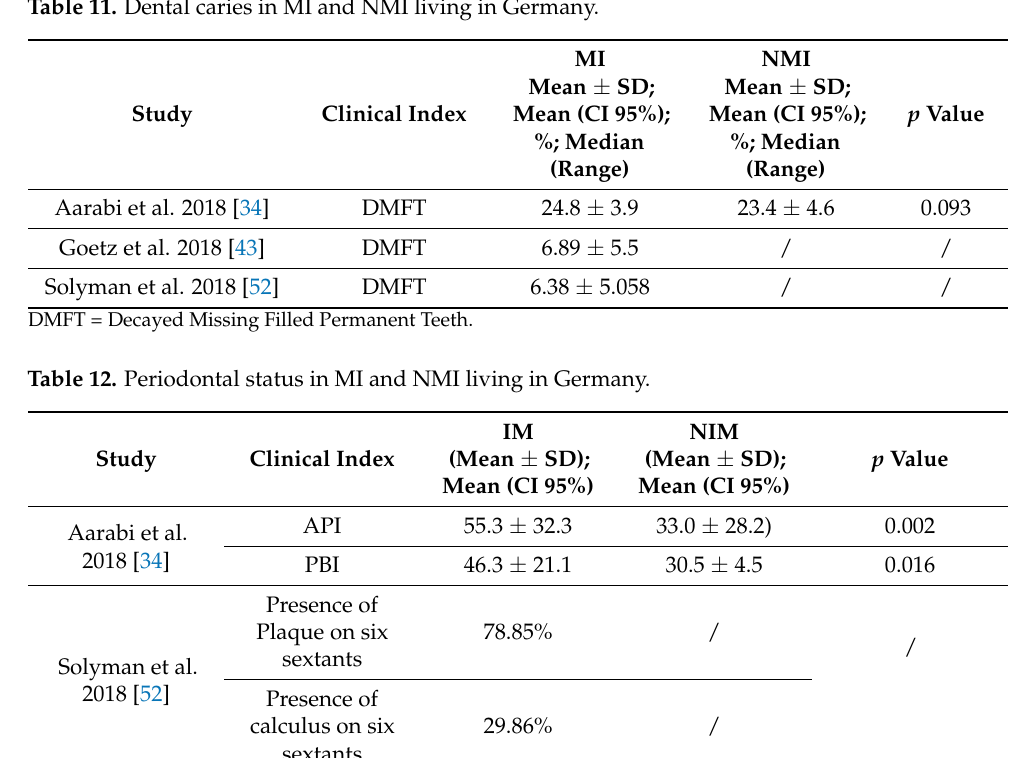
Table 11. Dental caries in MI and NMI living in Germany.